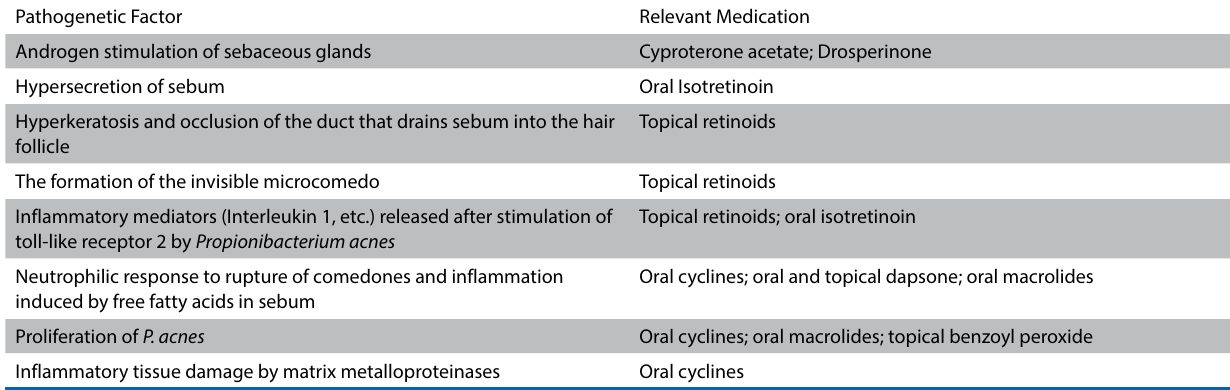
Table 1. Main pathogenetic factors in acne and corresponding treatments Pathogenetic